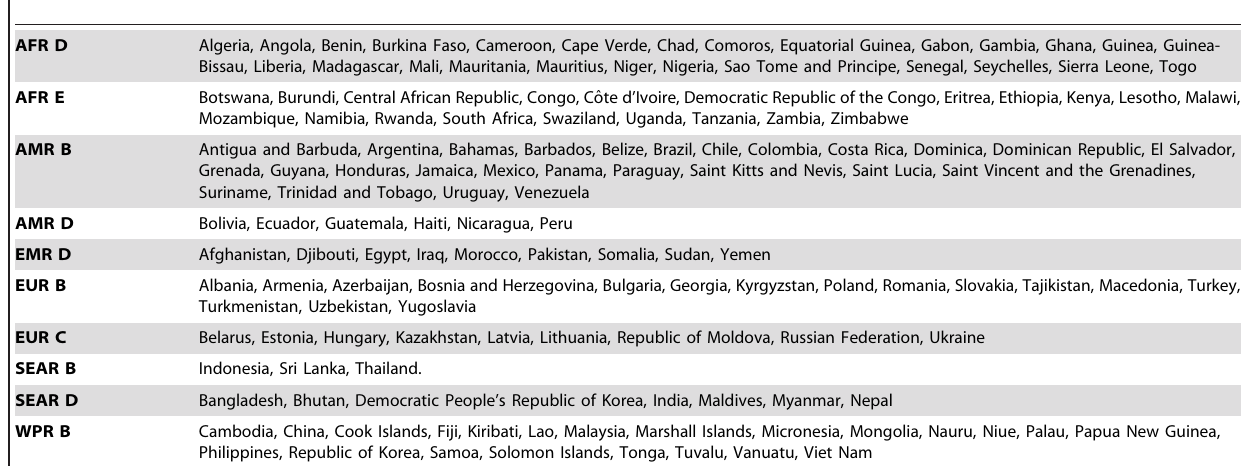
Table 1. Regions of the world (developing and transitional economies) as defined during the 2000 Global Burden of Diseases